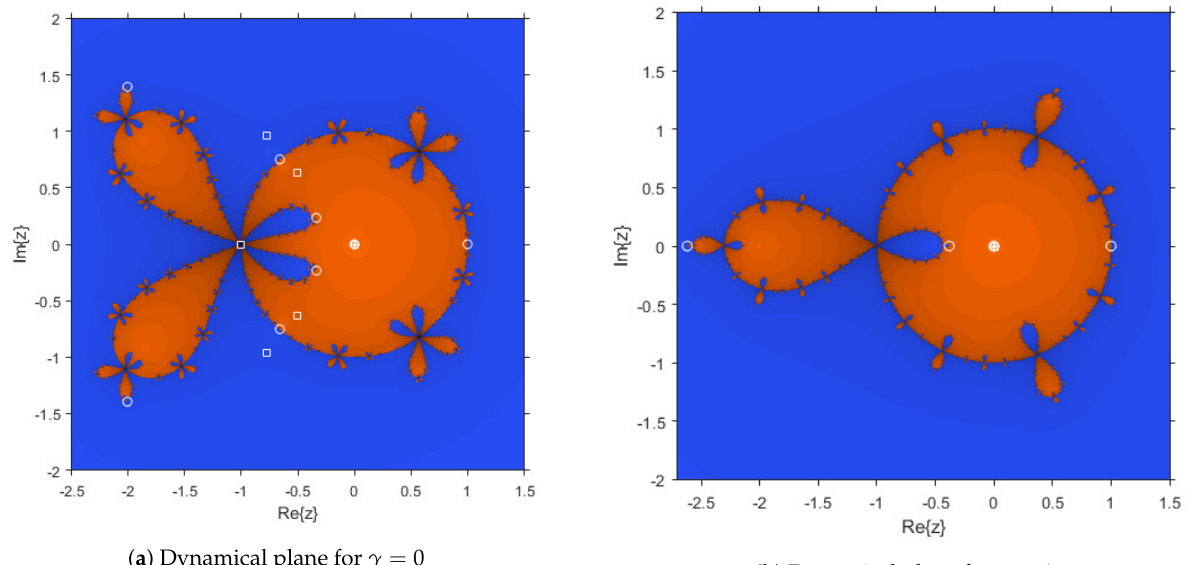
Figure 3. Dynamical planes of γ = 0 and γ =